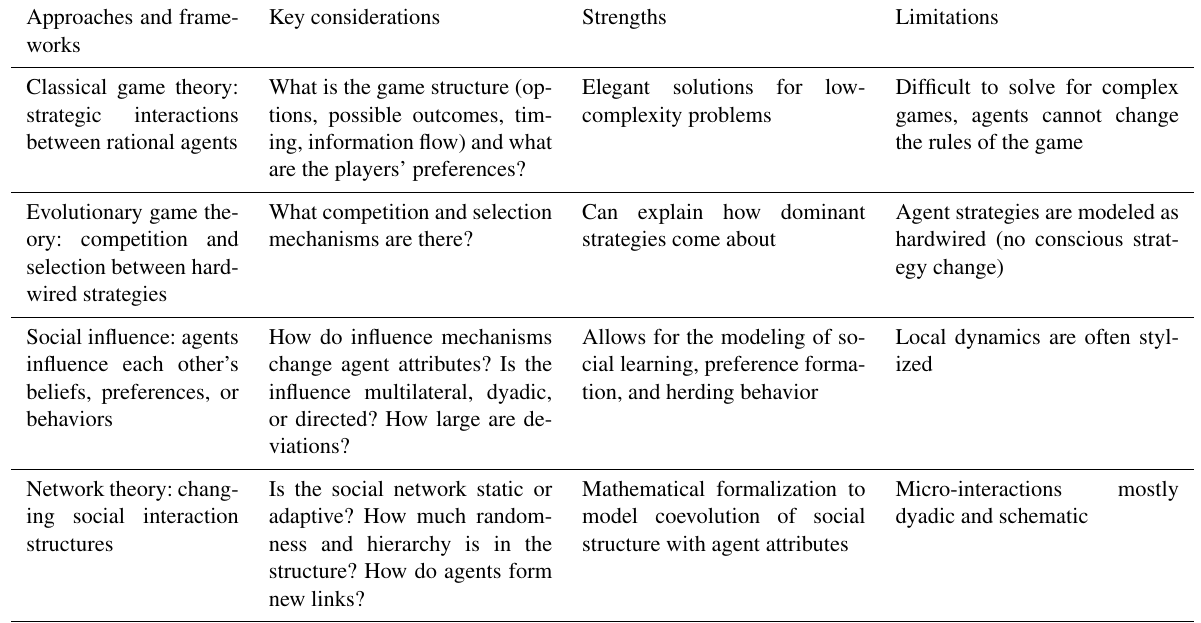
Table 3. Summary table for agent interactions. Approaches and